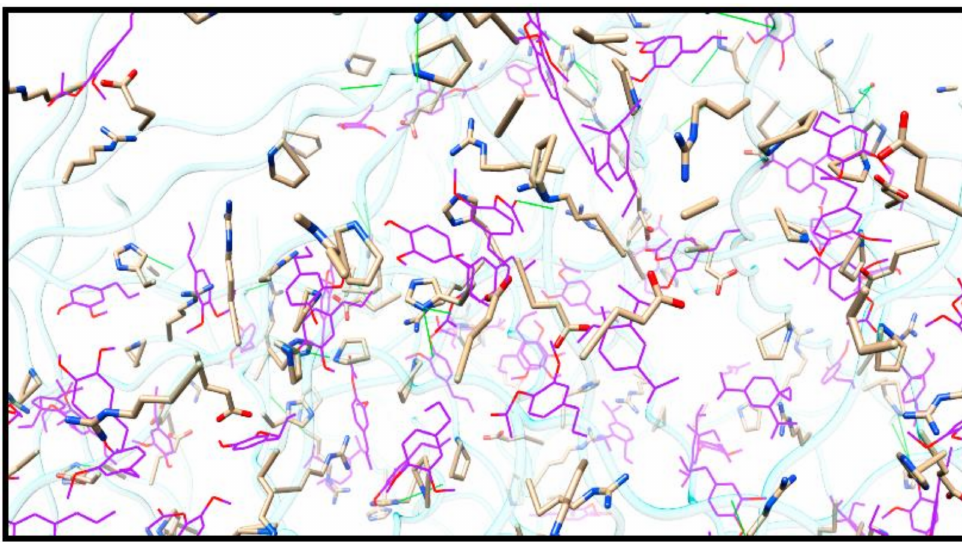
Figure 2. View of the EO-impregnated biofilm in greater detail, showing the side chains of the amino acids that interact with the EO molecules (colour purple). Sticks are used to symbolize the side chains of amino acids, while the wire is used to represent EO compounds. Hydrogen bonds are represented by the green lines. Atoms are represented by colour; for example, oxygen is red, and nitrogen is blue (Adopted from Cruz et al.